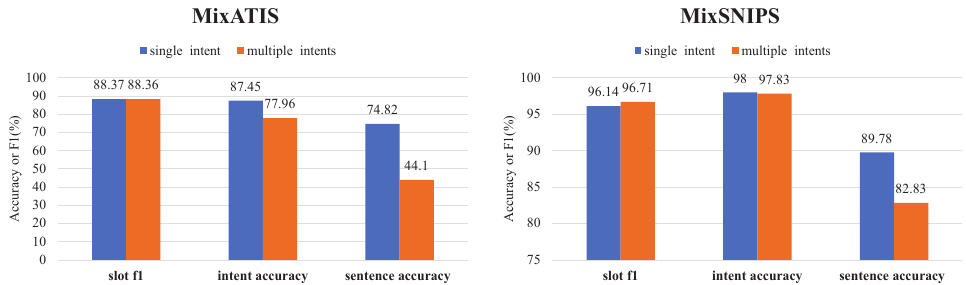
Figure 4. Accuracy of single-intent and multi-intent comparison plots.